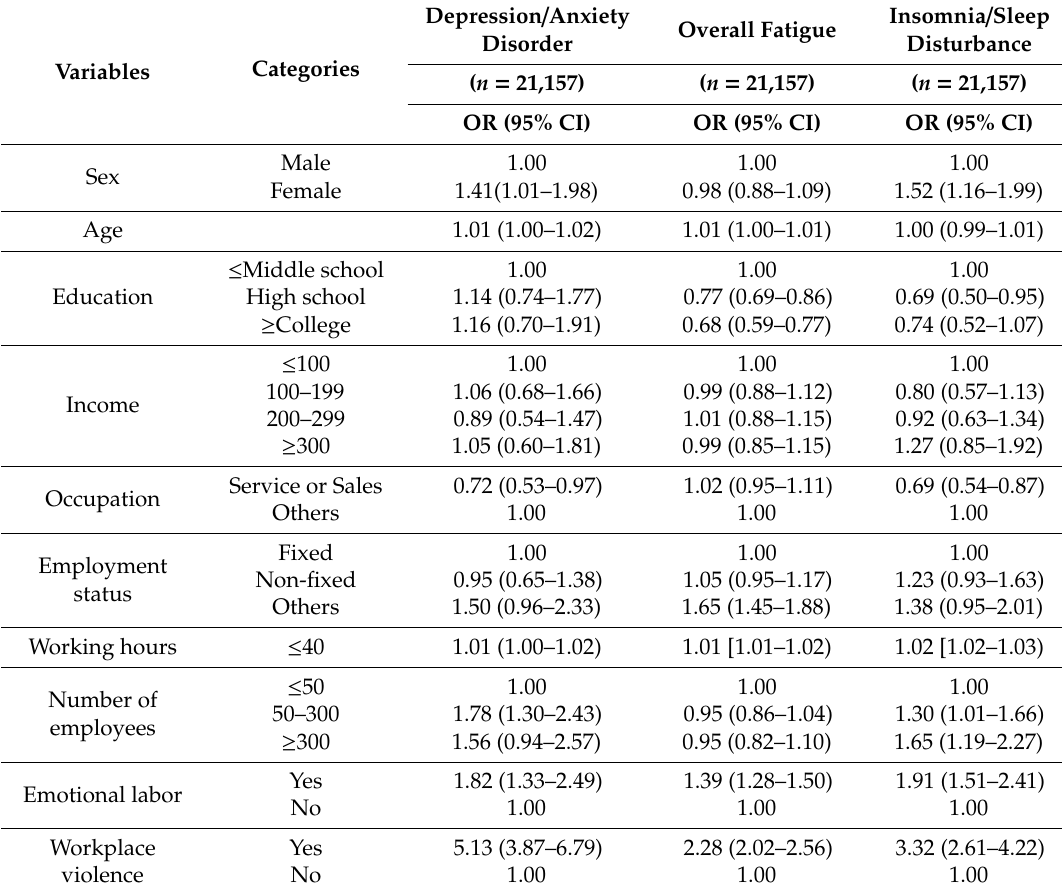
Table 5. Impact of Emotional Labor and Workplace Violence in Mental Health